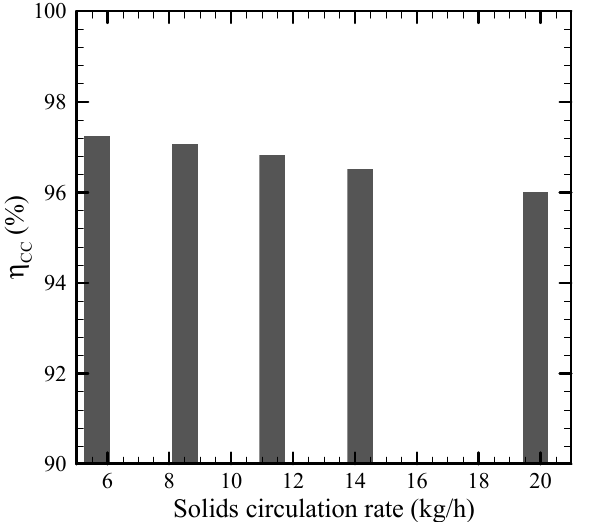
Figure 8. Performance of the carbon capture as a result of the circulation rate of solids.